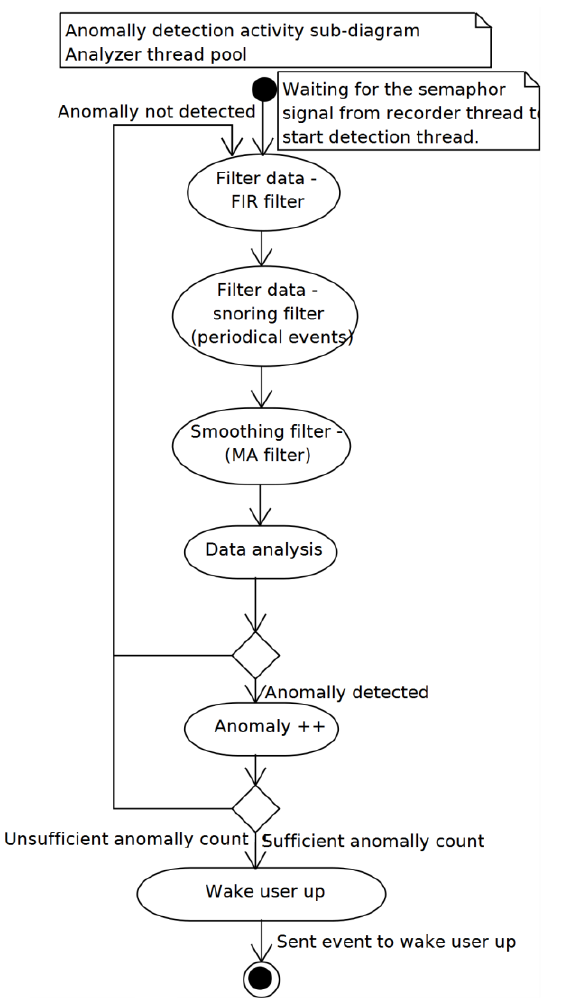
Figure 5. Analysis thread UML activity